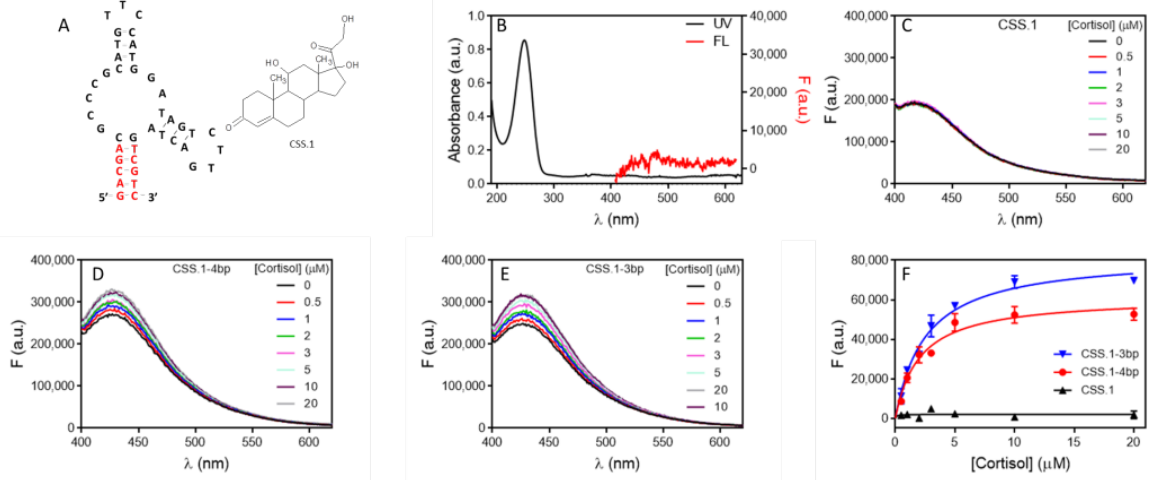
Figure 2. ( A ) The structure of the aptamer and cortisol. ( B ) UV-vis spectra of 50 uM cortisol and its fluorescence spectra when excited at 340 nm. The fluorescence of the ( C ) 5 bp ( D ) 4 bp and ( E ) 3 bp aptamers upon titration of cortisol. ( F ) The fitted binding curve of the three aptamers. 2.3. Hg 2+ Binding to Poly-T DNA Enhances Fluorescence.